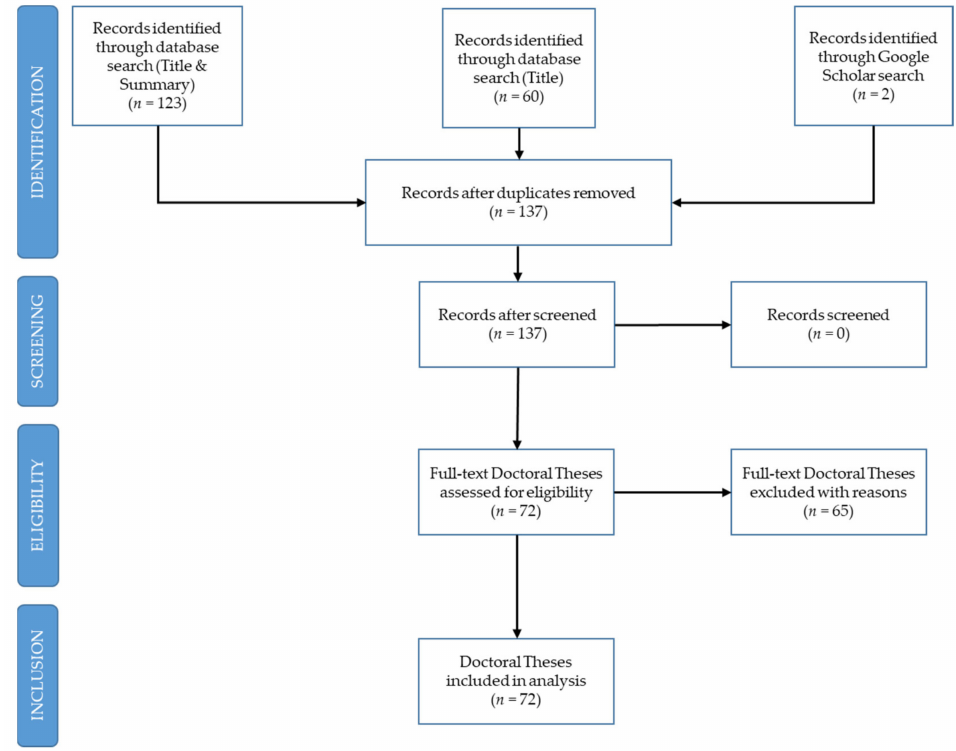
Figure 1. Flow diagram based on the PRISMA guidelines [7] of the methodology used in the search for doctoral theses on